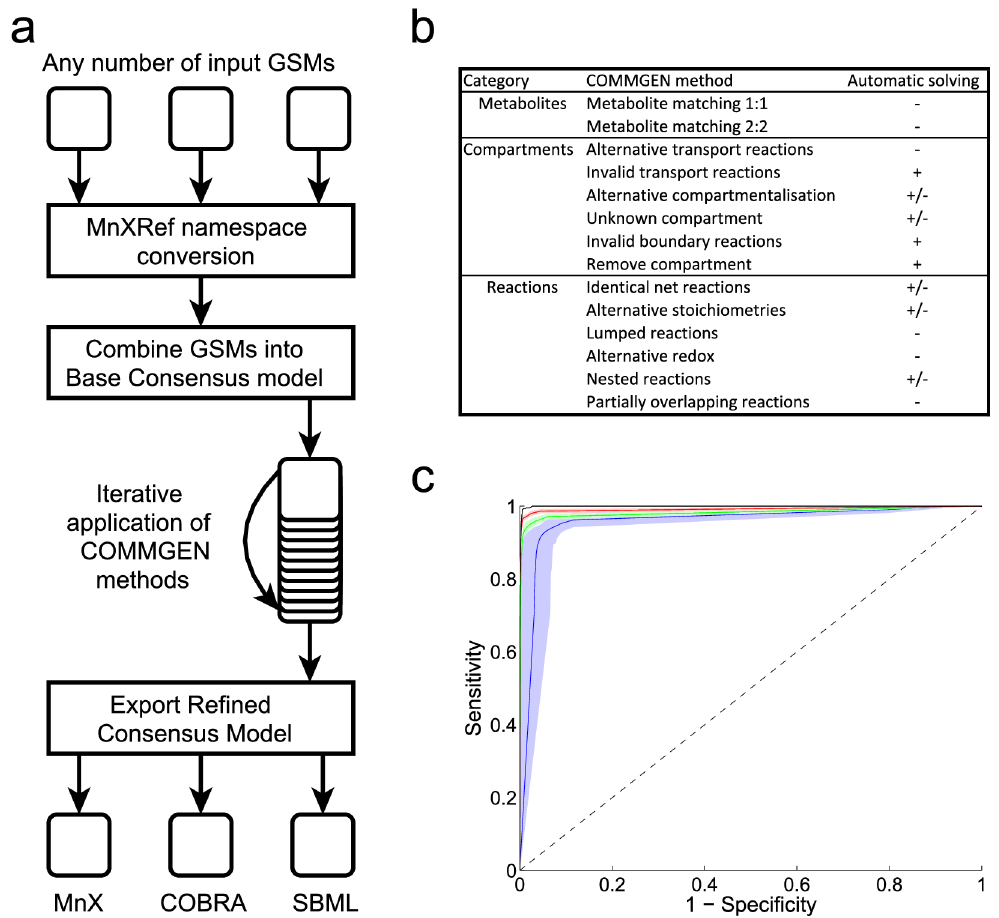
Fig 2. COMMGEN framework. ( a,b ) Overview of COMMGEN workflow and available methods. The COMMGEN methods are either fully automatic (+), conditionally or optionally automatic (+/-), or they always require manual intervention (-). ( c ) Performance of the metabolite matching methods if run without manual intervention, leading to ROC-curves of the classification of metabolites as identical or non-identical based on their network context. Lines correspond to different fractions of the network information being randomly discarded: black, 0%; red, 30%; green, 60%; blue, 90%. The shades indicate the standard deviations in the classification. The data presented here was obtained using the Pseudomonas putida GSMs iJP962 [10] and iJN746 [33]; analysis results for the other sets of GSMs and additional information can be found in S5